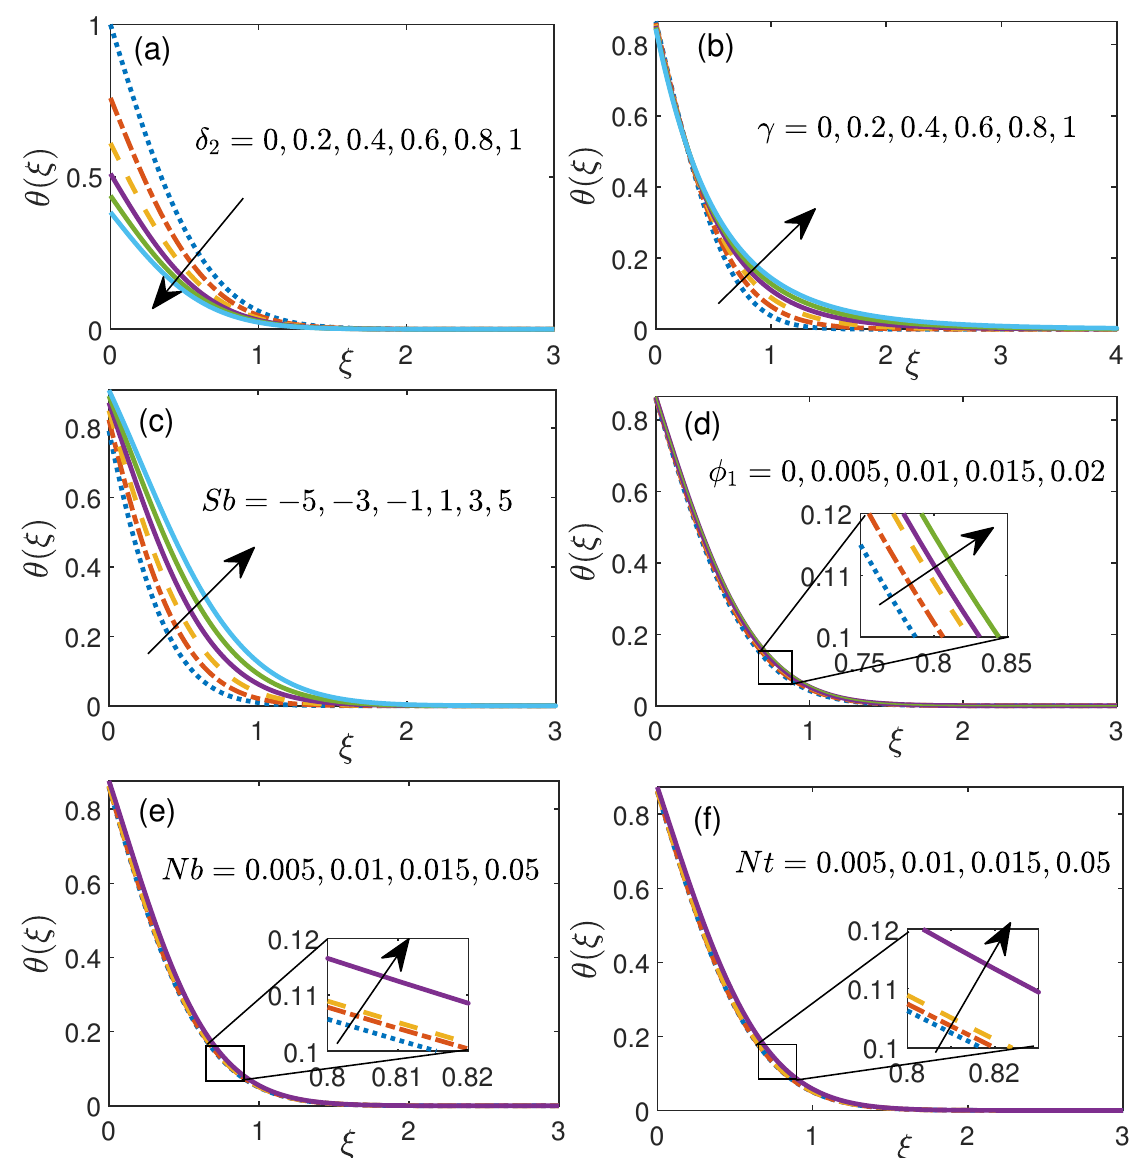
Figure 4. Temperature profile for ( a ) thermal slip parameter δ 2 , ( b ) curvature parameter γ , ( c ) Stefan blowing Sb , ( d ) initial volume fraction φ 1 , ( e ) Brownian motion Nb , ( f ) thermophoresis Nt